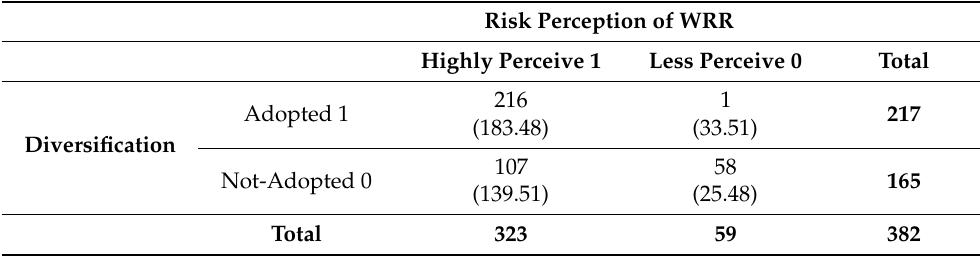
Table 9. Observed and Estimated Expected (in Parentheses) Counts for farmers risk perception of flood and their choice to adopt diversification as a risk management strategy.